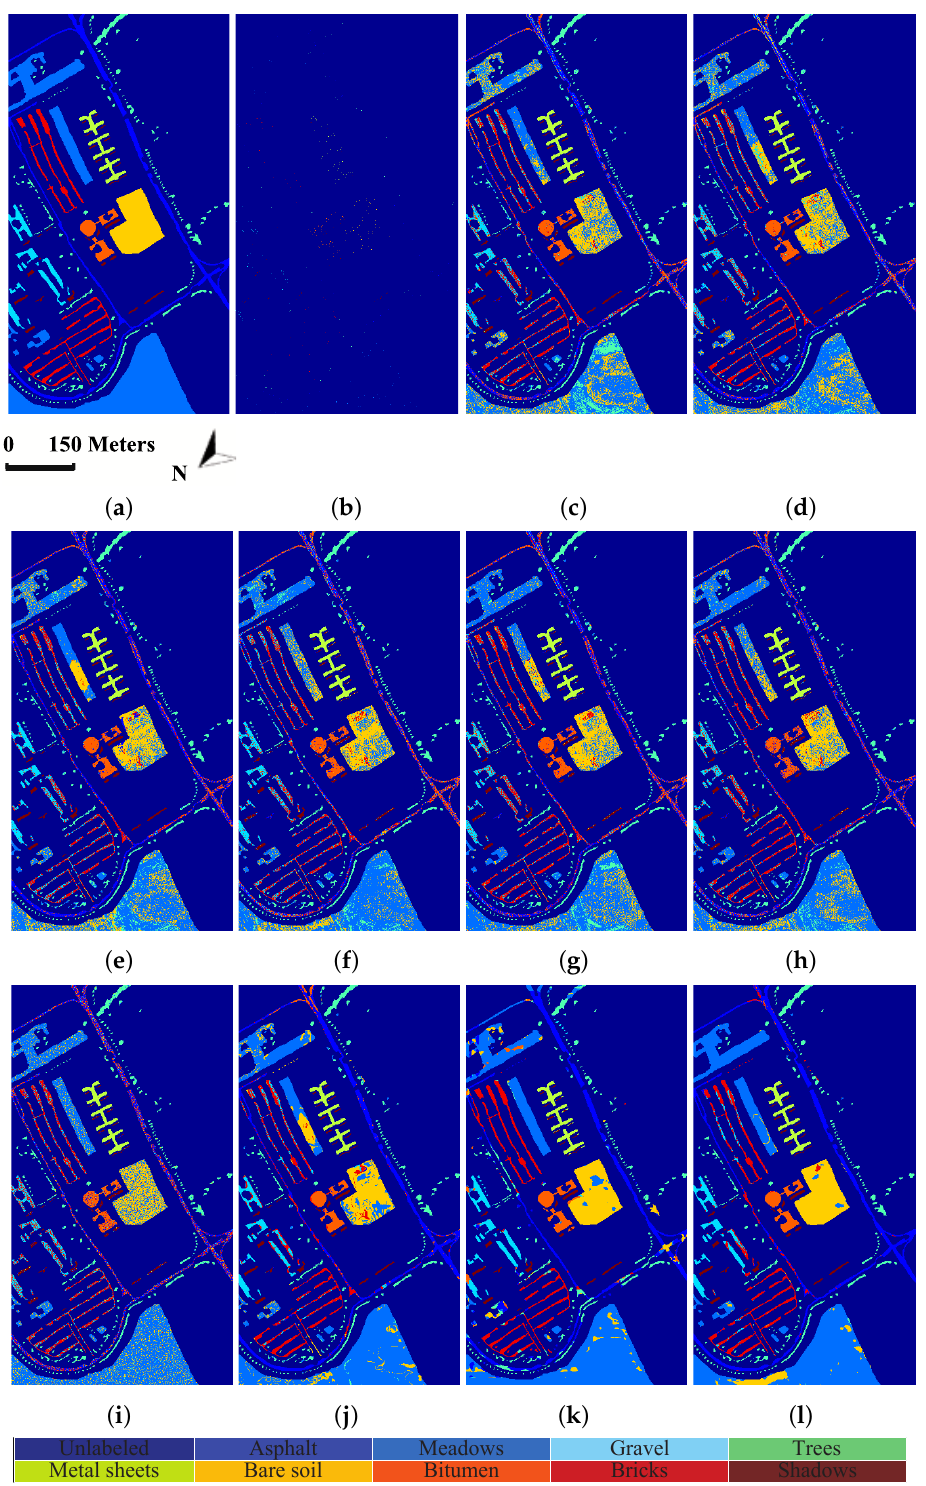
Figure 6. Classification maps of different methods for the University of Pavia dataset: ( a ) ground truth; ( b ) training set; ( c ) origin; ( d ) PCA; ( e ) LDA; ( f ) LFDA; ( g ) SGDA; ( h ) GDA-SS; ( i ) SLGDA; ( j ) MPCA; ( k ) G-LTDA; and ( l )